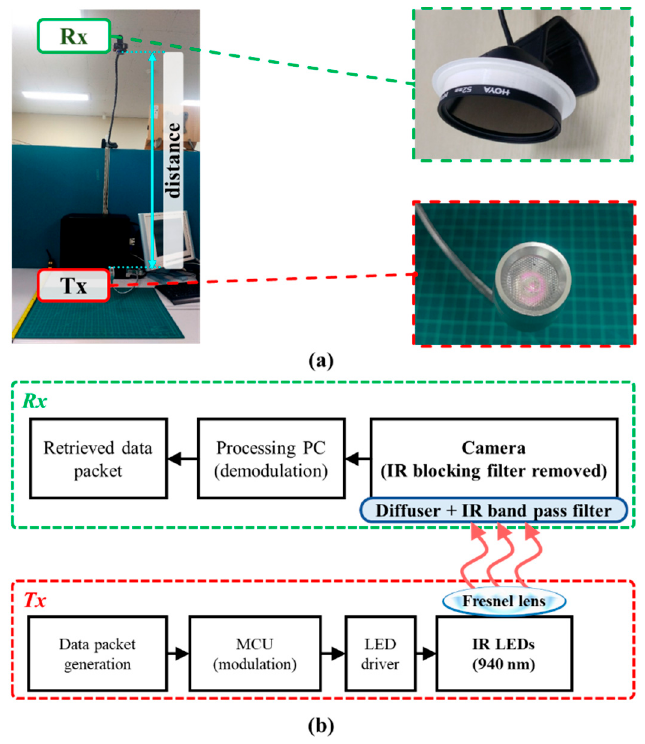
Figure 27. IOCC: ( a ) experiment setup; ( b ) block diagram [91].